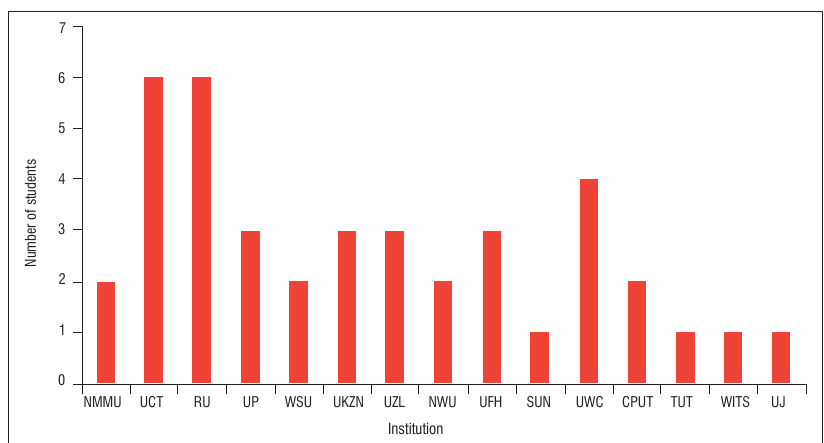
A histogram showing the range of universities represented on board the 2016 SEAmester